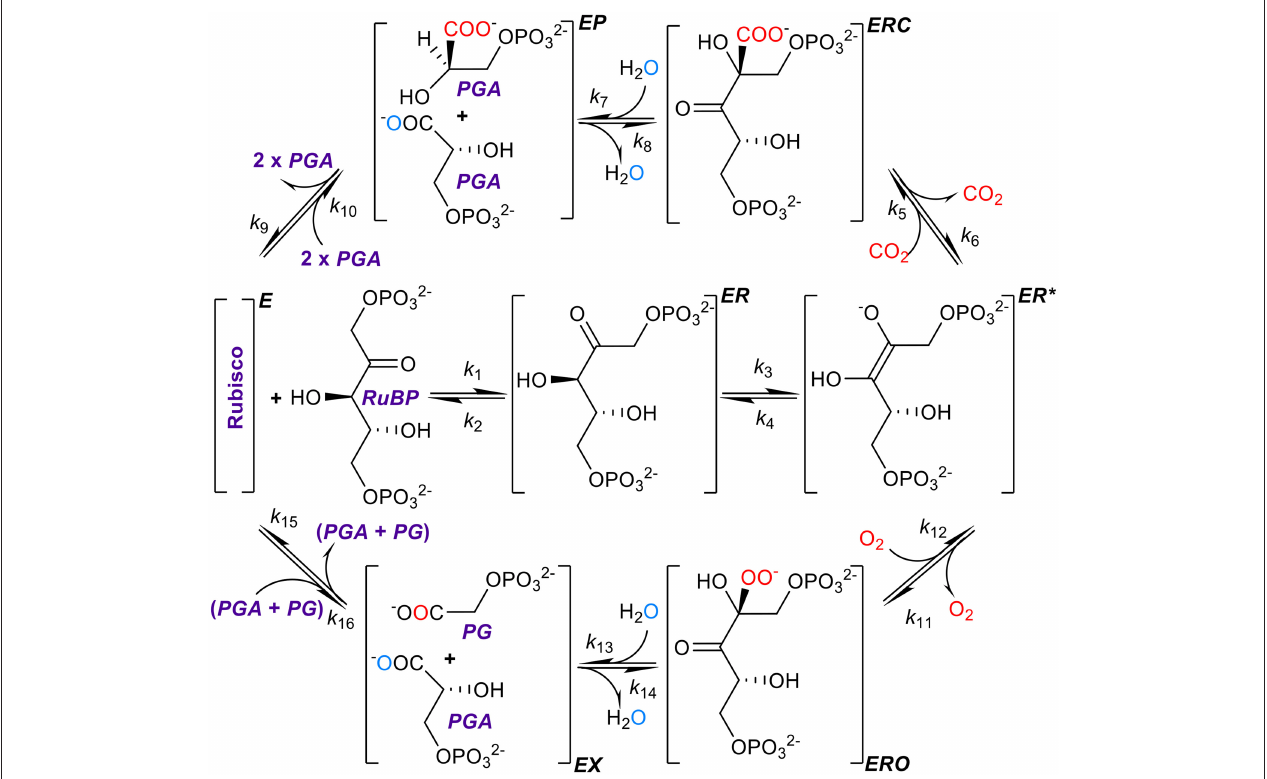
FIGURE 1 | The kinetic mechanism of RuBisCO. RuBisCO must first be activated by carbamylation and binding of Mg 2 + before it processes three substrates, ribulose bisphosphate (RuBP), and carbon dioxide or oxygen, the complete reactions taking place over several stages (Lorimer, 1981; Cleland et al., 1998; Andersson, 2008; Kannappan and Gready, 2008). RuBP binds first forming a complex ( ER ) with the activated form of the enzyme ( E ), followed by enolization of RuBP ( ER *) which facilitates binding with the carbon dioxide or oxygen molecule to form the ERC or ERO enzyme-substrate complexes. After hydrolysis, the six-carbon compound formed by the addition of carbon dioxide to RuBP breaks at a C-C bond forming a product complex ( EP ) which dissociates into two three-carbon compounds, 3-phosphoglyceric acid ( PGA ), with the addition of two protons. Oxygenation proceeds through analogous steps except that the dissociation products are one PGA molecule and one of 2-phospho-glycolate ( PG ). Atoms originating from free CO 2 and O 2 are shown in red, and oxygen atom originating from the water molecule used for hydration is shown in aqua